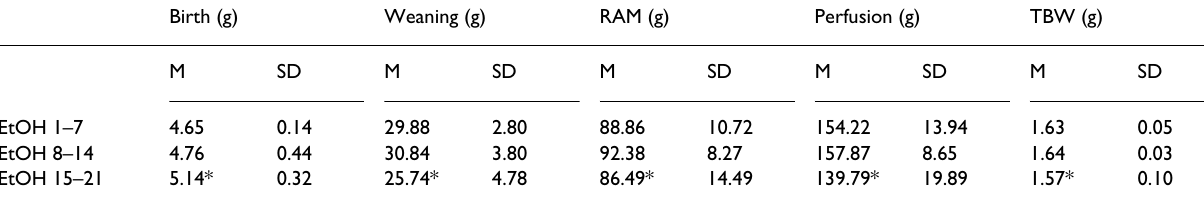
Table 4: Female Weight Data for EtOH weekly treatment groups. Birth (g) Weaning (g)